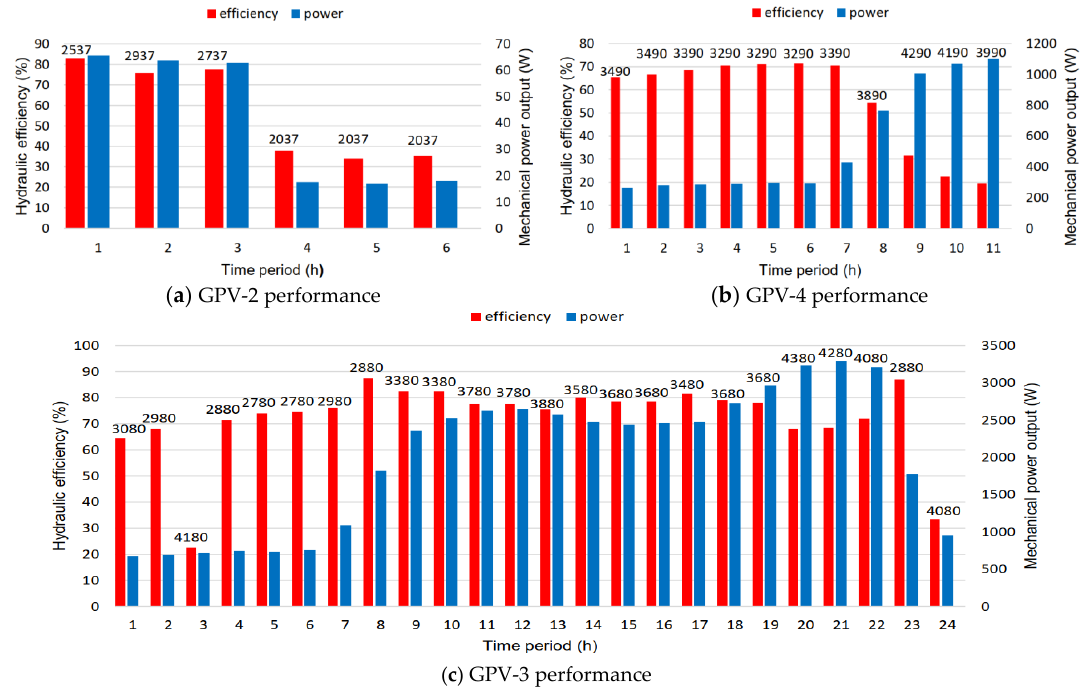
Figure 15. Requested and achieved head loss for all GPVs.